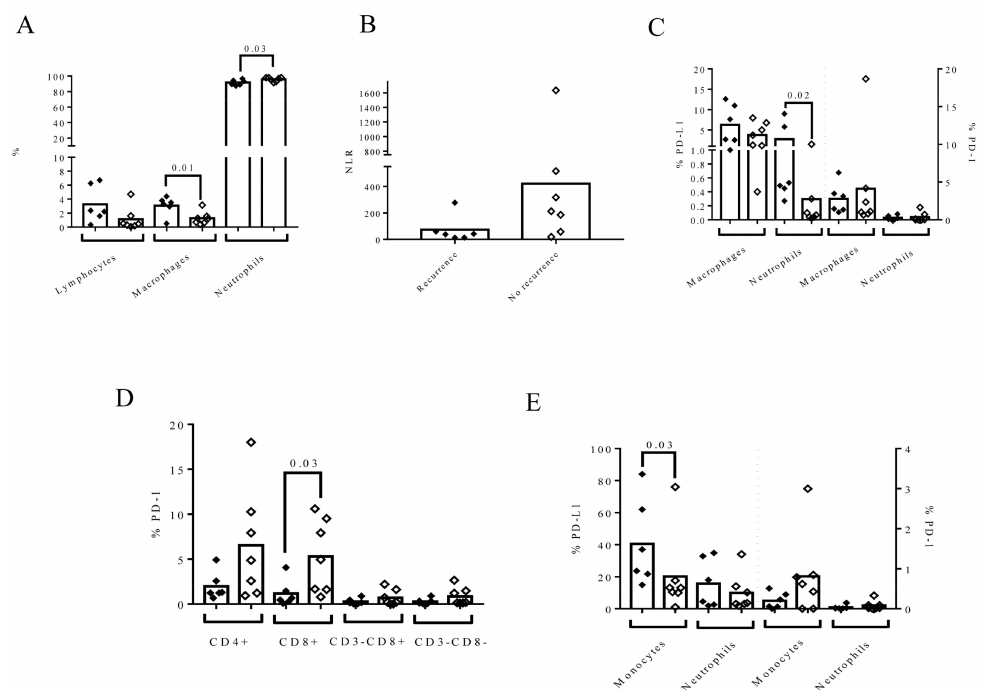
Figure 6. Urine and blood cell composition at the time of RC could predict recurrence in those patients who had not received neoadjuvant chemotherapy and were LN negative. At the time of RC, a different urine cell composition was observed between patients who recurred (black diamond) and patients who had not recurred (open diamond) during follow-up. The phenotype of lymphocyte subpopulation was not determined in MIBC patients since five patients had <1% of urine lymphocytes. ( A ) Percentage of urine lymphocytes, macrophages, and neutrophils gated inside the leukocyte population ( n = 13); ( B ) the urine NLR; ( C ) the expression of PD-L1 and PD-1 on macrophages and neutrophils in the urine of MIBC patients ( n = 13); ( D ) the phenotype of blood lymphocytes based on the expression of CD3 and CD8 ( n = 13); and ( E ) the expression of PD-L1 and PD-1 on macrophages and neutrophils in the blood of MIBC patients ( n = 13). The Mann–Whitney test was used for the comparison of independent